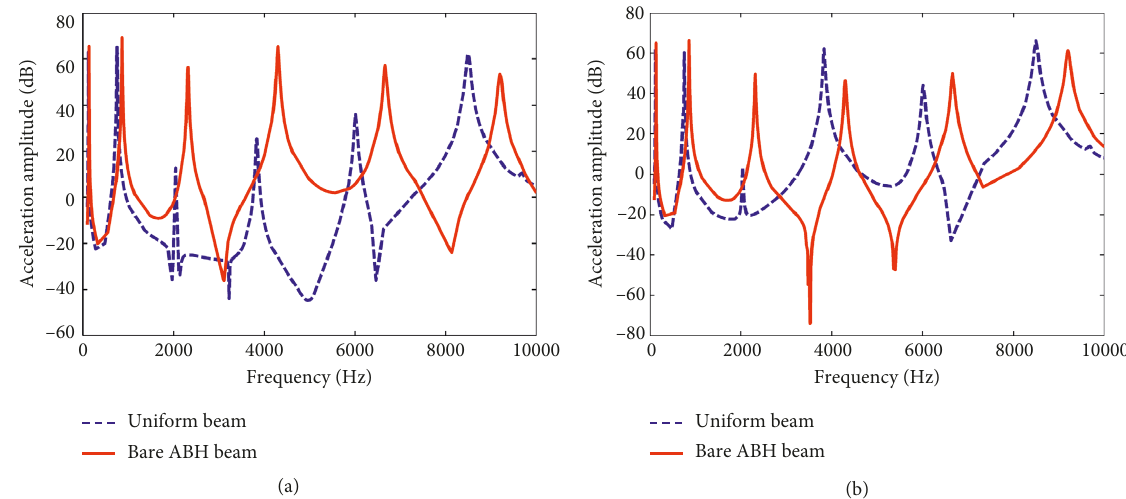
Figure 5: Acceleration responses of the bare ABH beam and the uniform beam: (a) ABH region ( x ( x m � 10 . 87